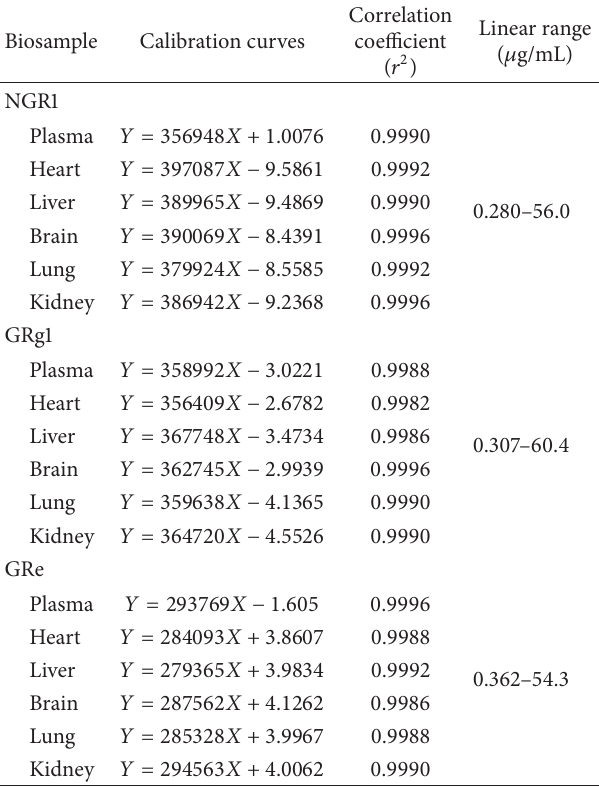
Table 1: Calibration curves for the analysis of NGR1, GRg1, and GRe in rabbit plasma and